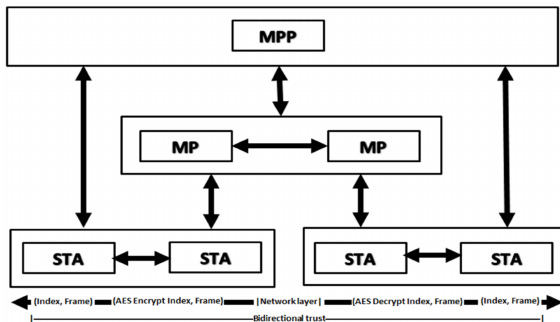
Figure 6. Proposed trust model.